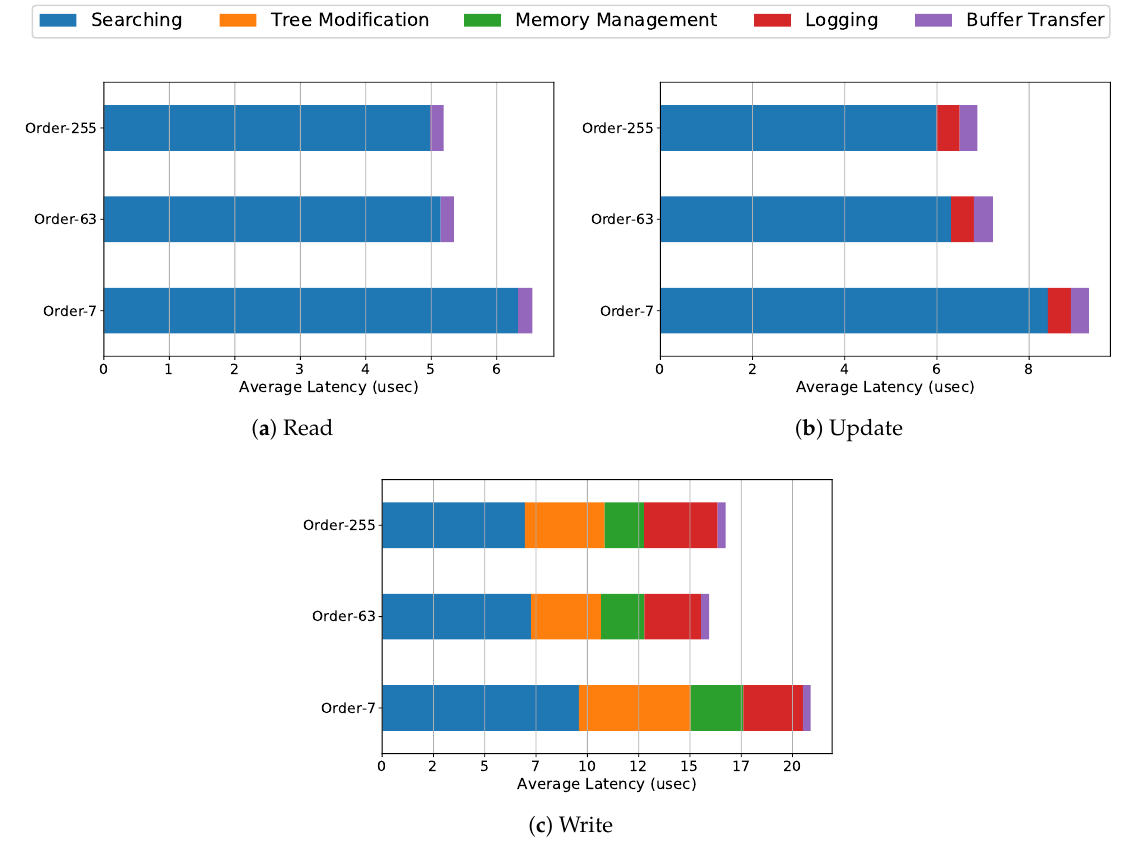
Figure 7. The breakdown of the latency for each key-value operation